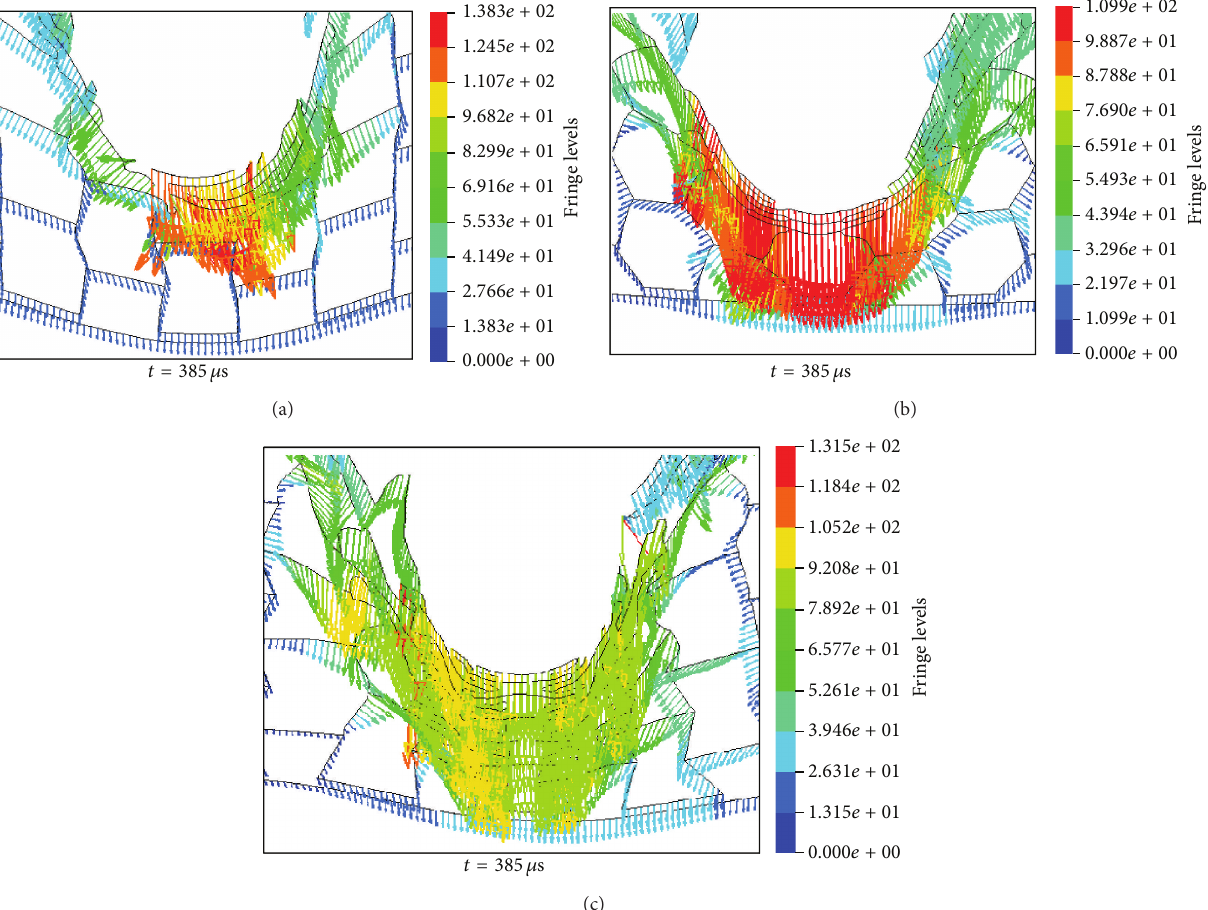
damage region nearest the projectile trajectory and 1.0